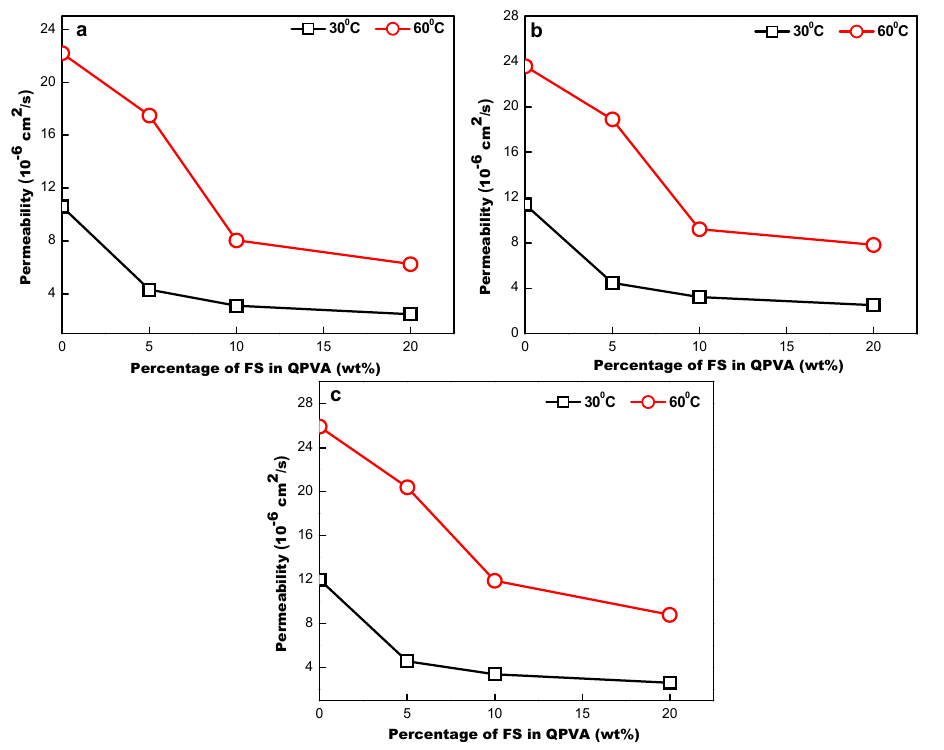
Figure 6. Methanol permeabilities of pristine QPVA and the QPVA/5% FS, QPVA/10% FS and QPVA/20% nanocomposite membranes at 30 °C and 60 °C at ( a ) 1 M; ( b ) 2 M and ( c ) 4 M methanol concentrations.